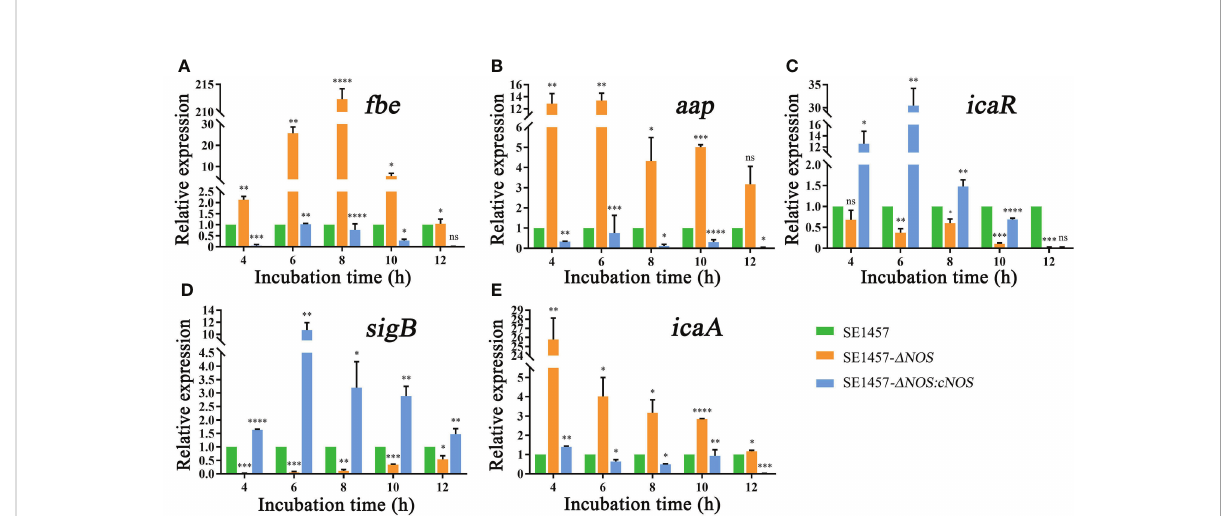
FIGURE 6 (A) Effects of NOS deletion on the transcriptional levels of fbe . (B) Effects of NOS deletion on the transcriptional levels of aap . (C) Effects of NOS deletion on the transcriptional levels of icaR . (D) Effects of NOS deletion on the transcriptional levels of SigB . (E) Effects of NOS deletion on the transcriptional levels of icaA . * p < 0.05, ** p < 0.01, *** p < 0.001, **** p < 0.0001, ns, not signi fi